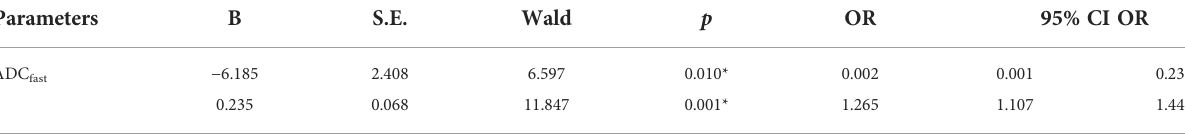
TABLE 3 The results of logistic regression analysis.